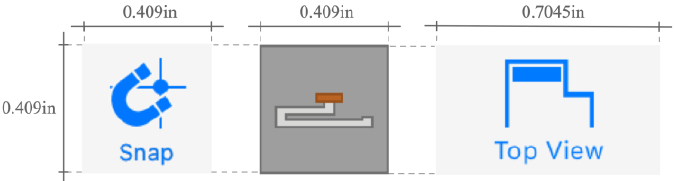
Figure 4. Several button types included in the GUI of the conceived multi-touch System and their corresponding sizes.